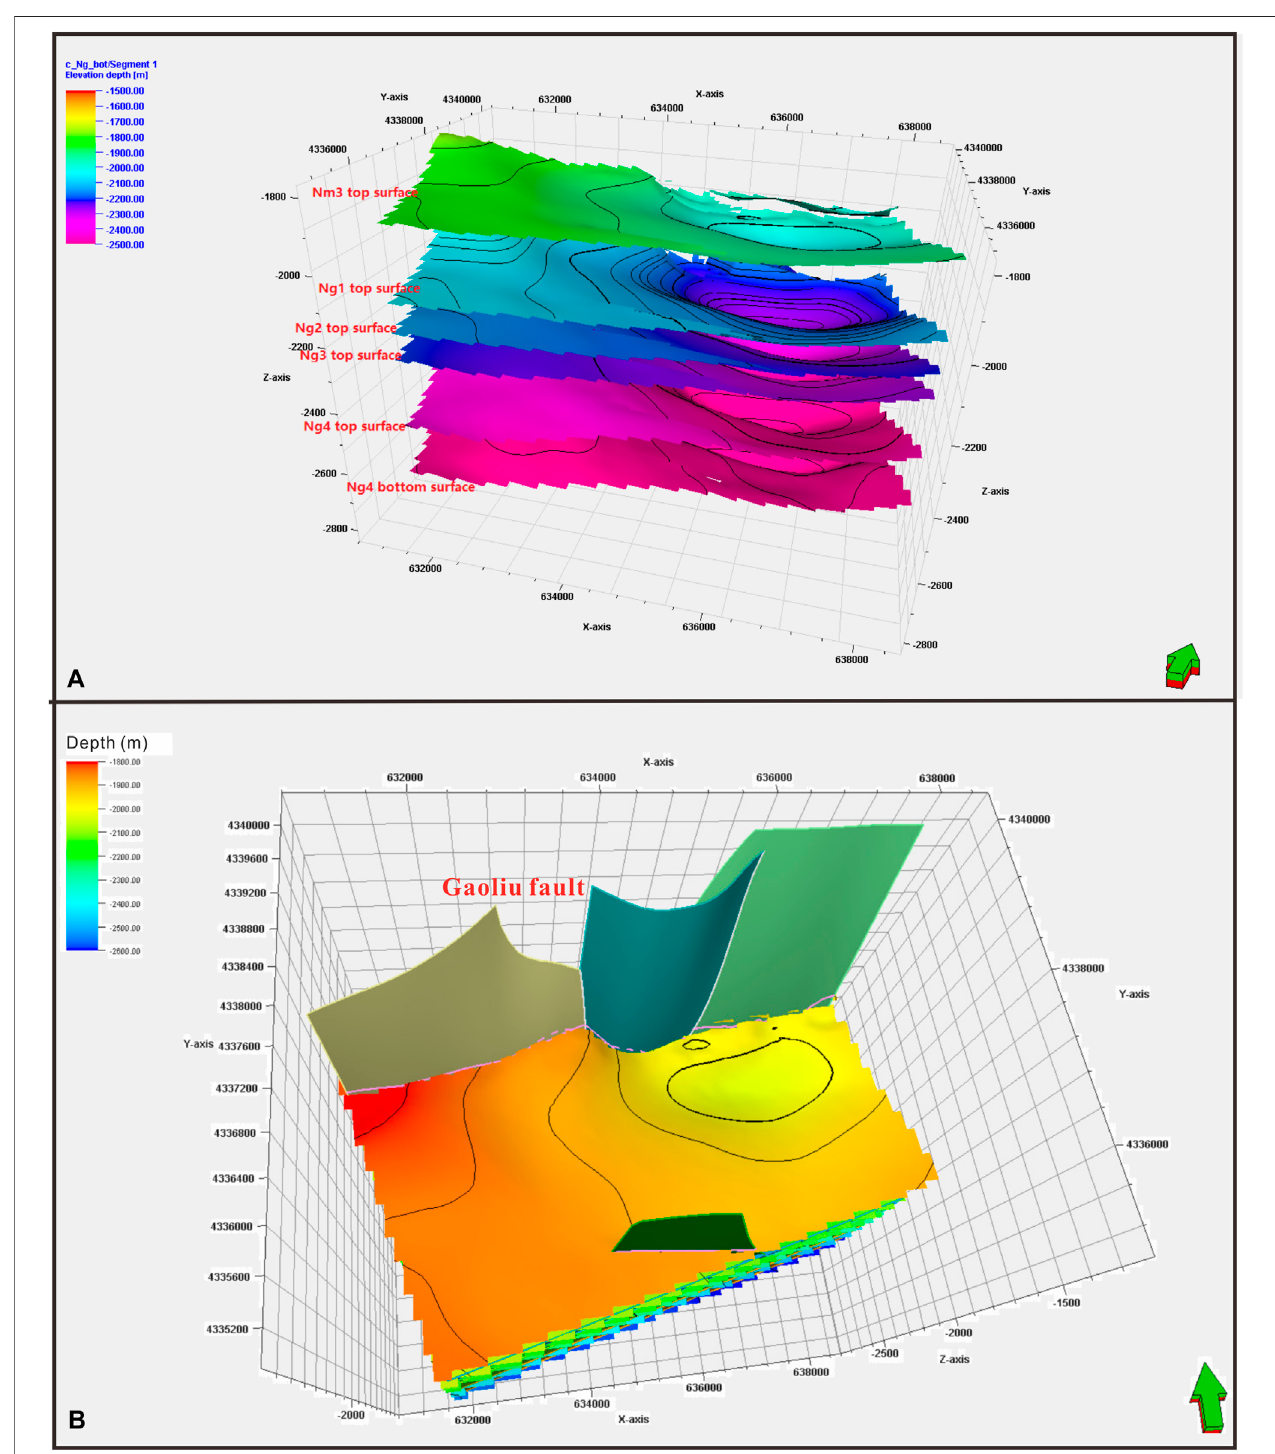
FIGURE 5 | Qualitative sketch of the 3D geological model. (A) The geological horizons of Minghuazhen and Guantao Formations (Nm3 and Ng1 – Ng4). (B) The geometry of the fault developments in the 3D geological model.